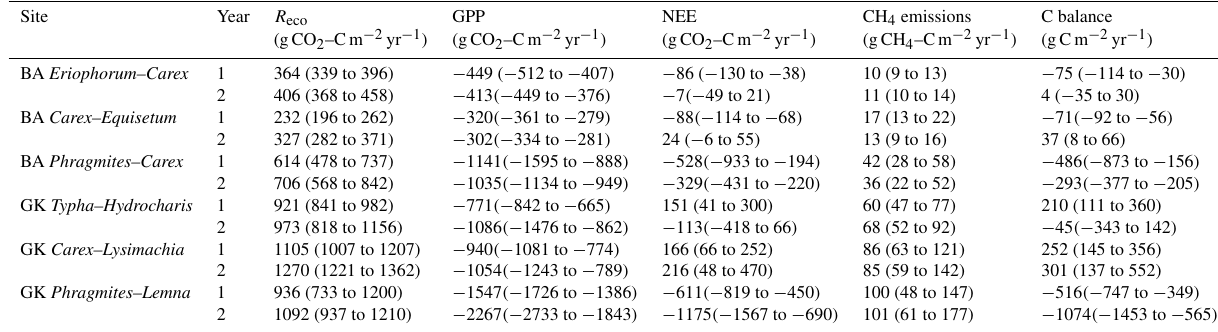
Uncertaintiesonthesitelevelincludetheuncertaintiesoftheplotmodelsandthespatialheterogeneity.Theywerecalculatedbypoolingtheplotspecificannualmodelsderivedbyerrorcalculation.DifferentCO 2 balancesoftheHapproachandtheLSapproachwereaccountedforbyaddingthedifferencesrandomlyto50%oftherespectiveannualvaluesderivedbyerrorcalculationwiththeHapproach.Toderiveuncertaintiesof CbalancestheannualmodelsofNEEandCH 4 derivedbyplot-wiseerrorcalculationweresummarizedandcombinedsite-wise.